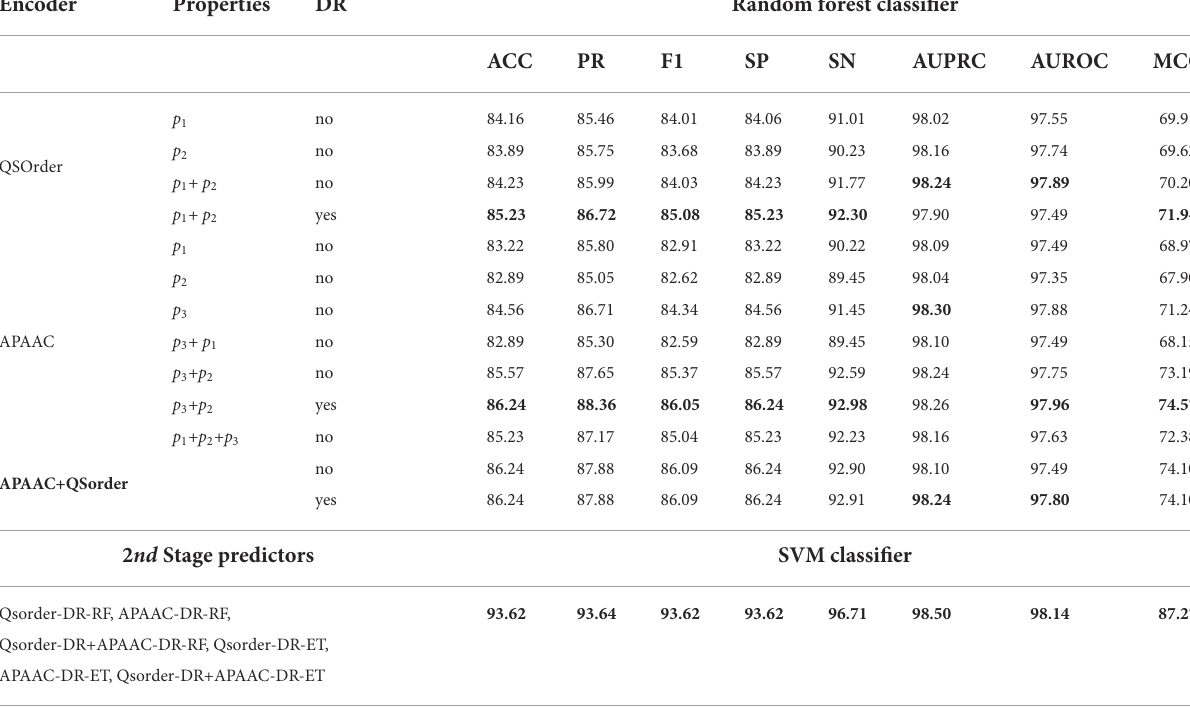
TABLE 2 Performance comparison of different statistical representations across 1st stage RF classifier and with iterative feature learning based 2nd stage SVM classifier.